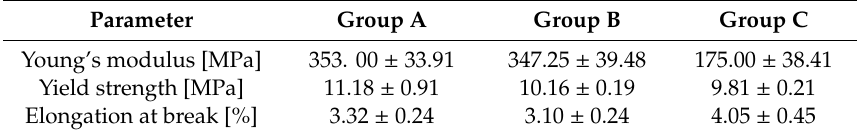
Table 4. Results of the bending tests.